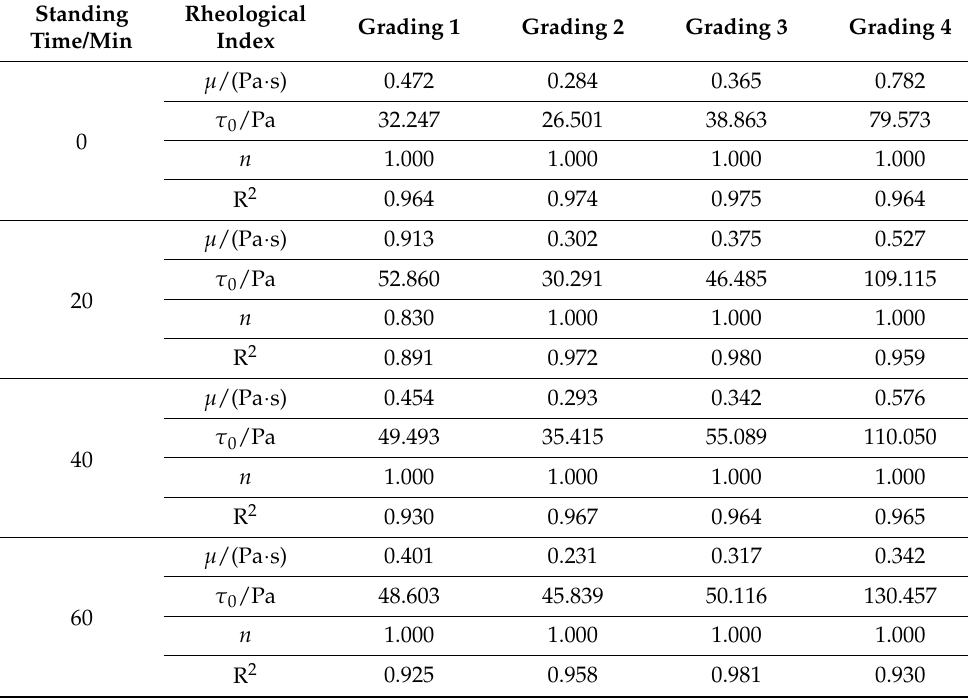
Table 5. Rheological parameters of filling paste at 70% mass